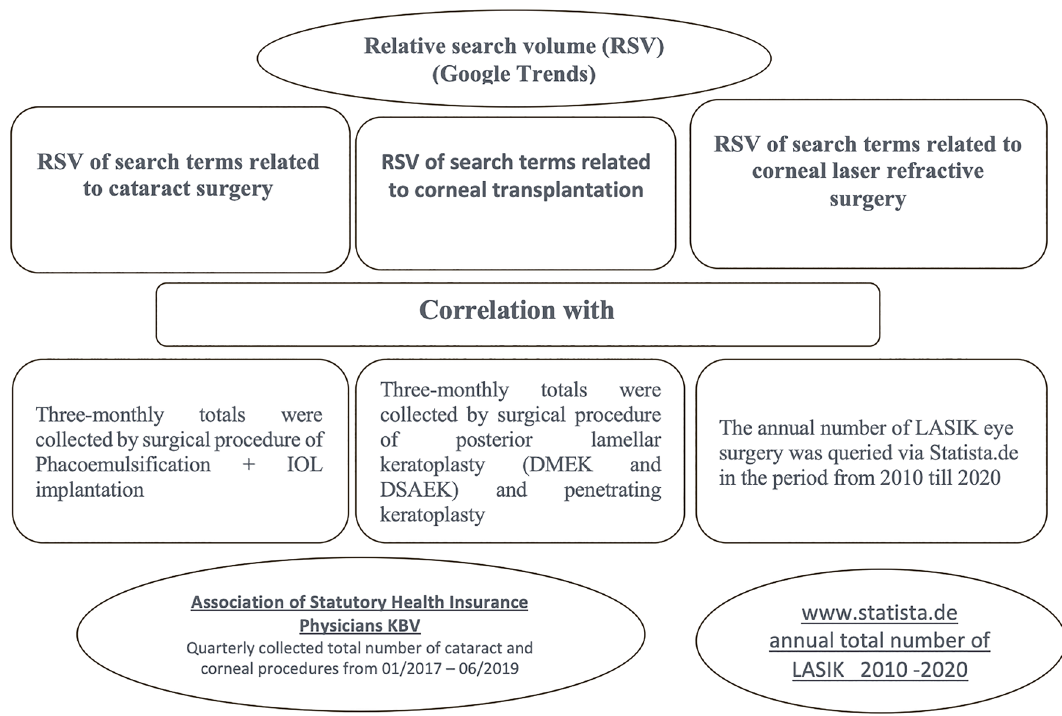
Figure 1. Overview of data acquisition and correlation in this study. Pearson correlation was calculated between the Relative Search Volume (RSV) of surgery specific terms and the number of corresponding procedures done in